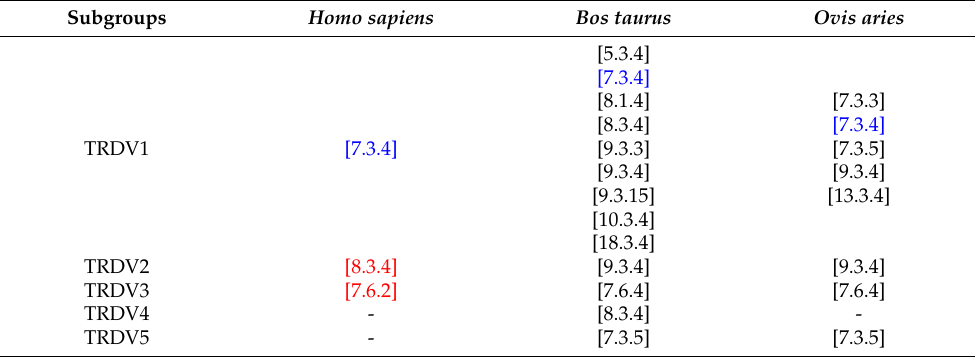
Table 10. TRDV [CDR1-IMGT.CDR2-IMGT.CDR3-IMGT] lengths by subgroup and species in human ( Homo sapiens ), bovine ( Bos taurus ) and sheep ( Ovis aries ). Subgroups Homo